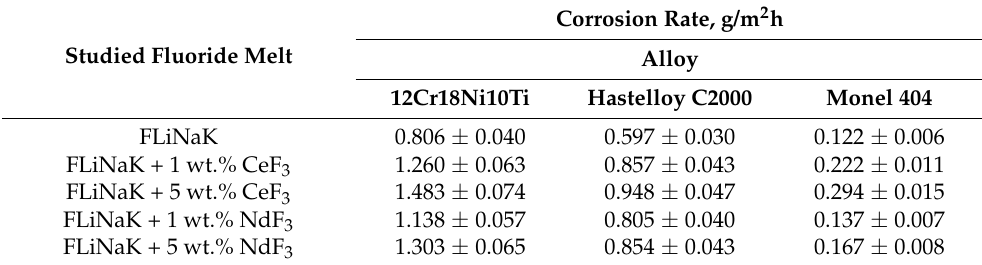
Table 2. Corrosion rate of the studied materials with an experiment time of 100 h.